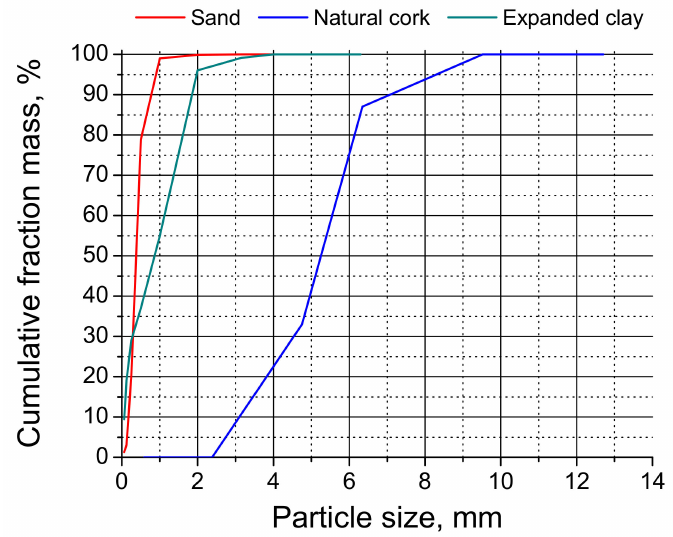
Figure 1. Particle size distribution of the aggregates